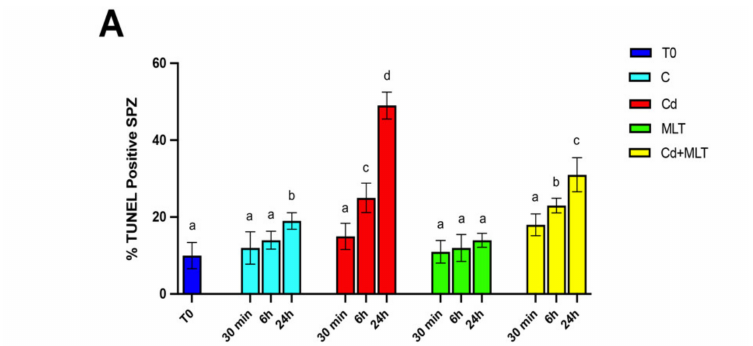
Figure 2. Determination of DNA integrity through the acridine orange (AO) staining of sperm samples incubated with Cd and/or MLT for 30 min, 6 h, and 24 h. ( A ) Percentage of positive AO cells. Values are expressed as means ± SEM from 15 samples divided into the five groups, including the initial control (T0). a vs. b p < 0.05; a vs. c p < 0.01; a vs. d p < 0.001; a vs. d p < 0.01; b vs. c p < 0.05; b vs. d p < 0.01; b vs. e p < 0.05; c vs. d p < 0.01; c vs. e p < 0.01; d vs. e p < 0.05. ( B ) AO staining, that highlight the SPZ with damaged DNA (yellow/orange) respect to those with intact DNA (green) in each analyzed time-points. Scale bars represent 10 µ